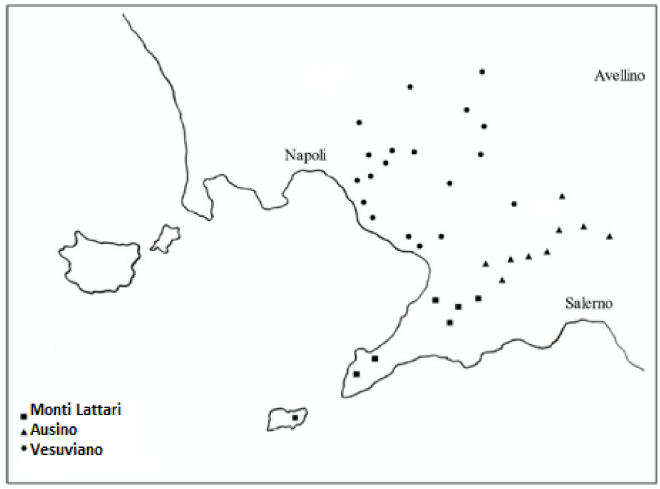
Figure 1. Schematic distribution of the water sources in Campania region for sample